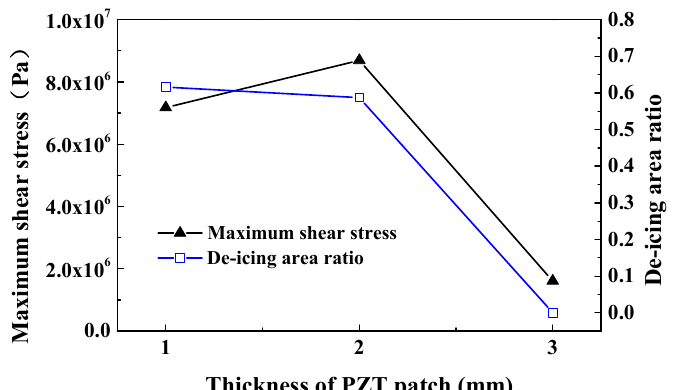
Figure 10. Maximum shear stress and the deicing area ratio changing with the thickness of the PZT patch.